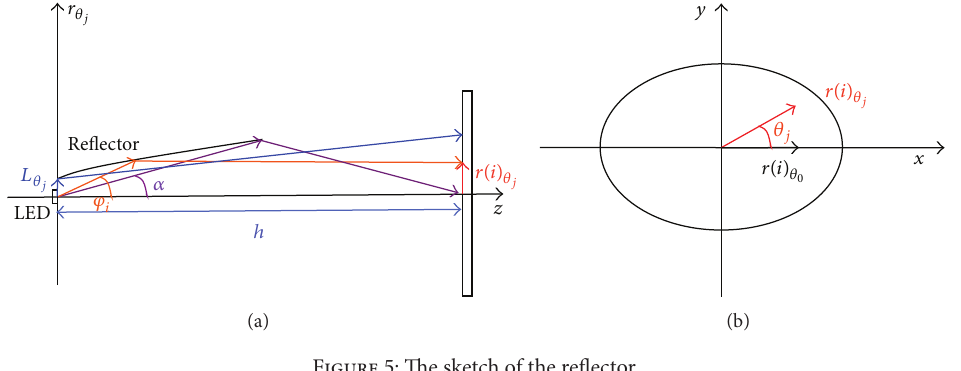
Figure 5: The sketch of the